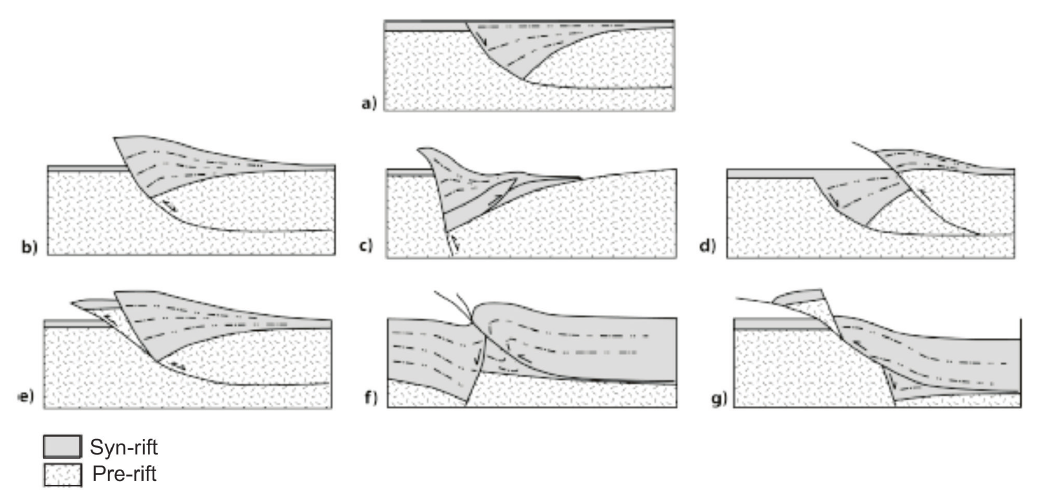
Figure 10. Basin inversion and resulting styles of structural architecture to be anticipated during crustal shortening (after Martínez et al., 2012; McClay, 1995): (a) early normal fault; (b) harpoon structure from partially inverted normal fault; (c) buttressing; (d) hangingwall is faulted forming hangingwall shortcut; (e) footwall shortcut thrust; (f) folding and truncation of normal fault by younger thrust; (g) thrust ramp above normal